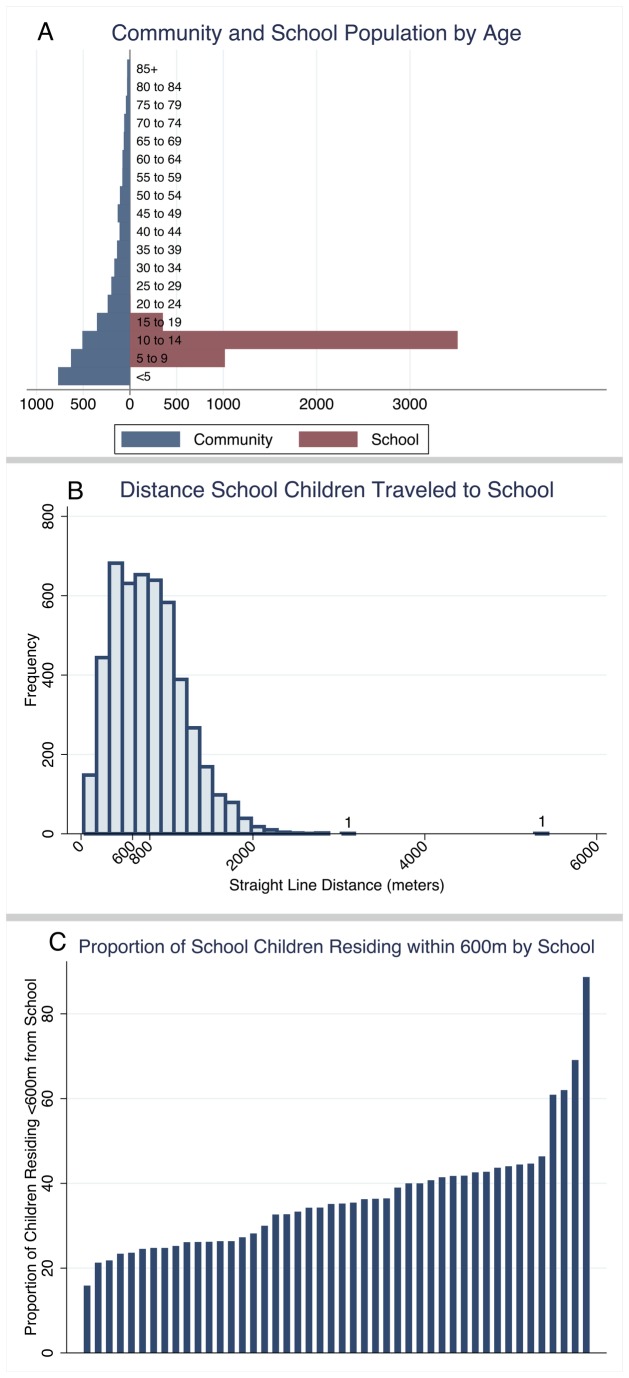
Characteristics of the study population – age and distance travelled to school.(A) A population pyramid showing the age distribution of those sampled in the community survey compared to those sampled during the school survey. (B) Histogram depicting the distance between the school and compound where each child resides. (C) The proportion of children sampled at each school that reside within 600m of the school.